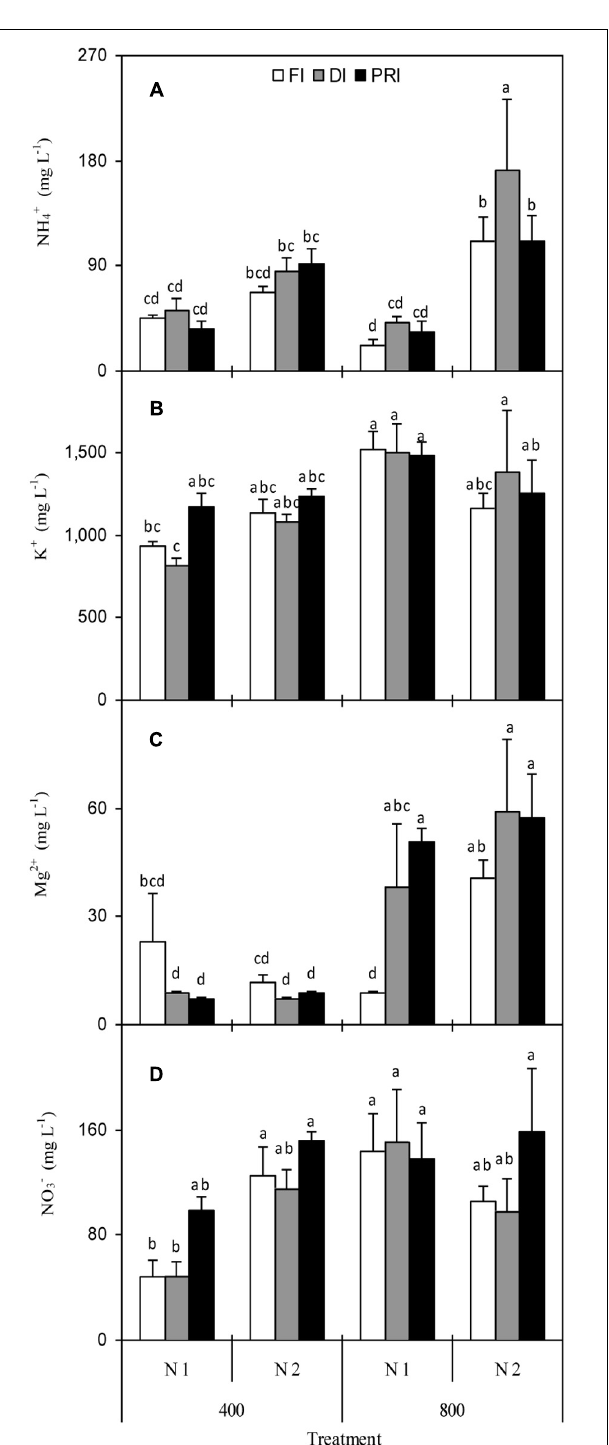
FIGURE 2 | Fresh fruit firmness (FM) (A) , total soluble solid (TSS) concentration (B) , organic acid (OA) concentration (C) , and sugar to acid ratio (SAR) (D) of tomato plants as affected by the atmospheric [CO 2 ] (400 and 800 ppm), N fertilization rates (N1 and N2), and irrigation regimes (FI, DI, and alternative PRI). Error bars indicate standard error of the mean ( n = 4). Different letters at each sampling data indicate significant differences between treatments according to LSD’s multiple range test at P < 0.05. Statistical comparisons among the treatments are presented in Table 1 .